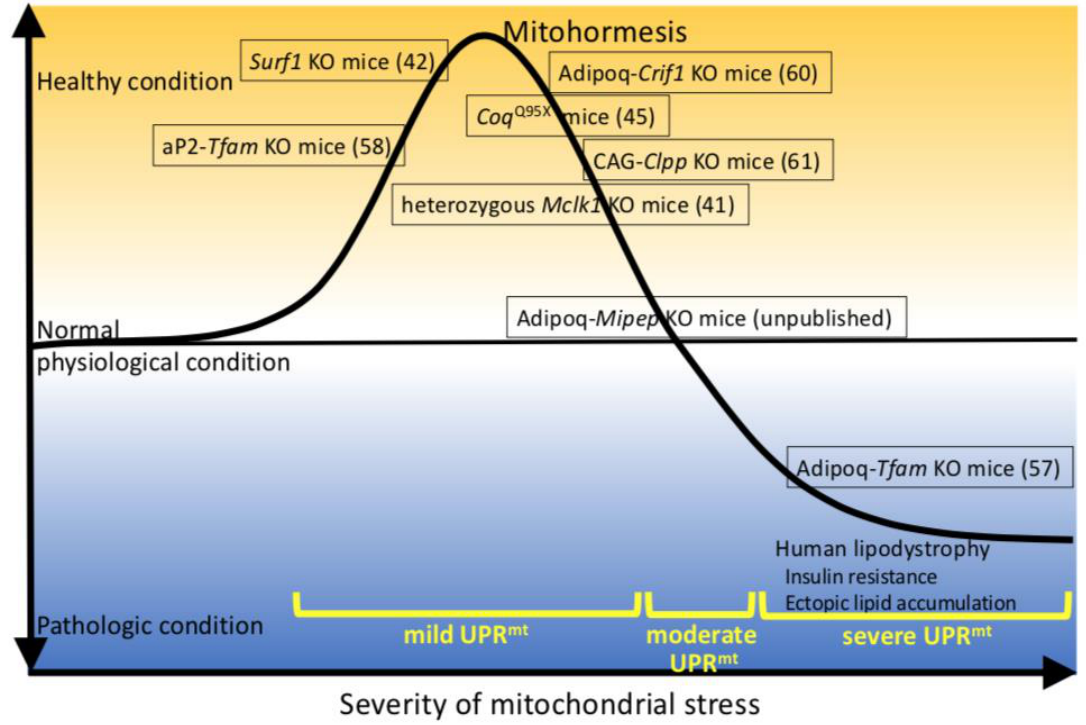
Figure 1. Proposed mechanism of interaction between the severity of mitochondrial stress and healthy conditions in mice based on findings derived from genetically modified mice, which develop lipoatrophy due to defective proteins involved in mitochondrial function. Numbers in parentheses indicate references.